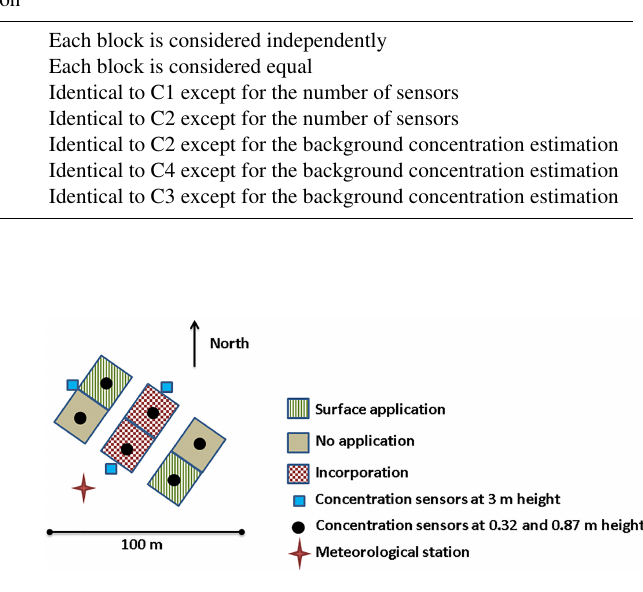
Figure 2. Scheme of the real experimental test case performed on six subplots with three treatments and two repetitions. Cattle slurry was either applied on the surface or incorporated. The concentra- tion sensor and meteorological station locations are shown on the